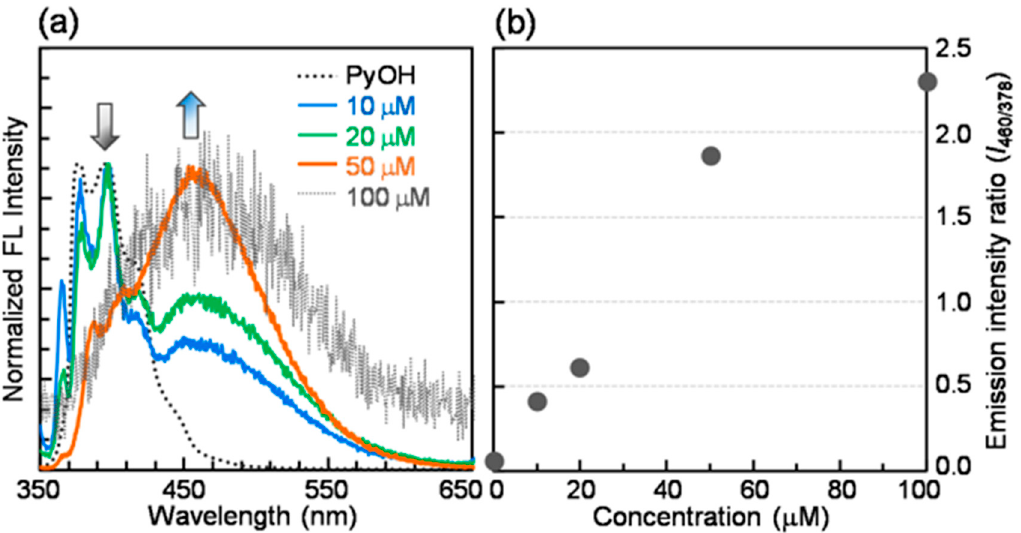
Figure 2. Concentration-dependent fluorescence quenching in DMF solutions. ( a ) Normalized fluores- cence spectra ( λ ex = 330 nm). ( b ) Emission intensity ratio ( I 460/378 ) of AzPy at different concentra ‐ tions.